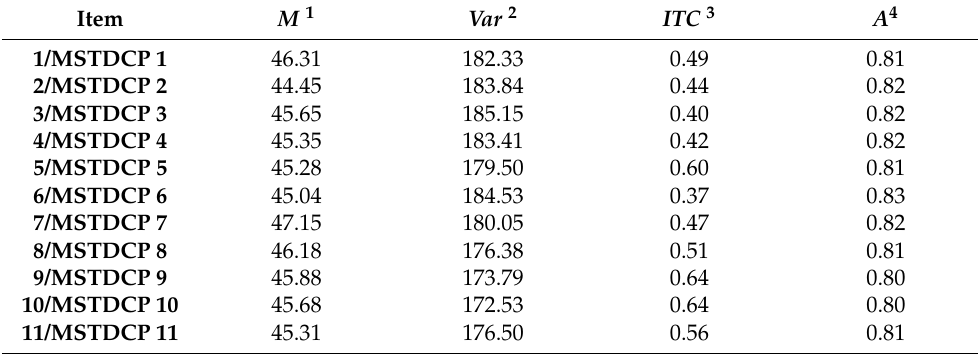
Table 5. Internal consistency of the Stress Scale.